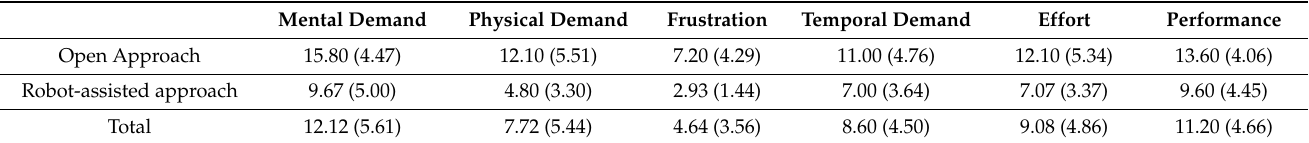
Table 5. Means and standard deviations (in parentheses) for the dimensions of the NASA